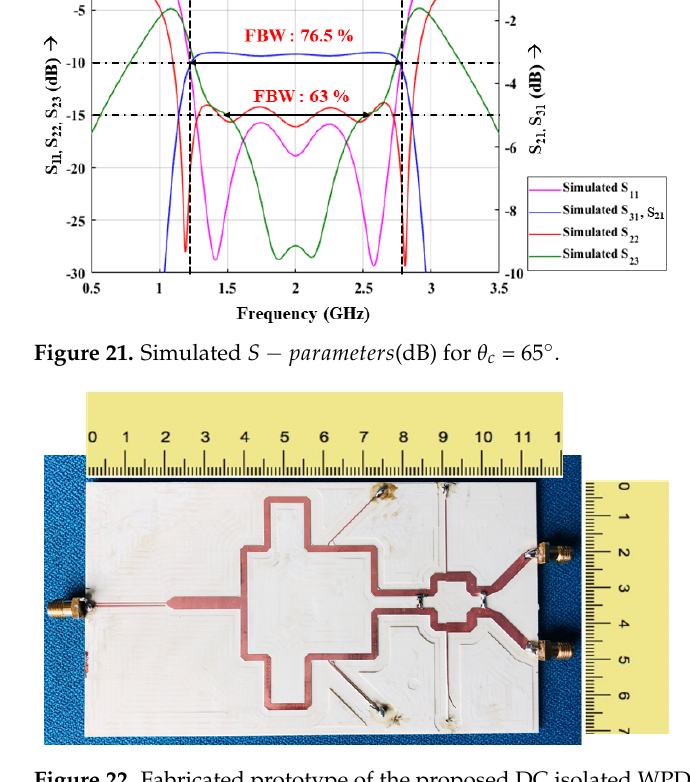
Figure 22. Fabricated prototype of the proposed DC isolated WPD.